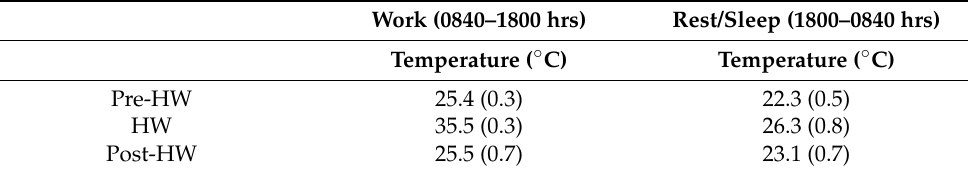
Table 1. Temperature during daily work and rest periods. Temperature is presented as a mean (SD) of each 3-day testing